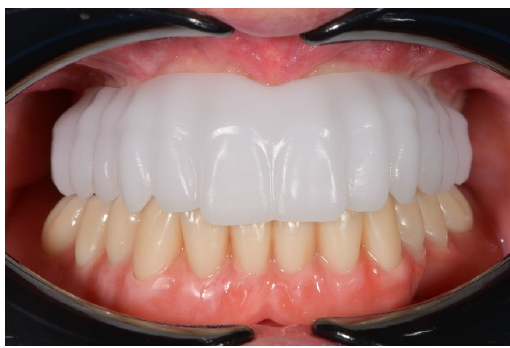
Figure 20. Temporary abutments connected to the aesthetic try-in.